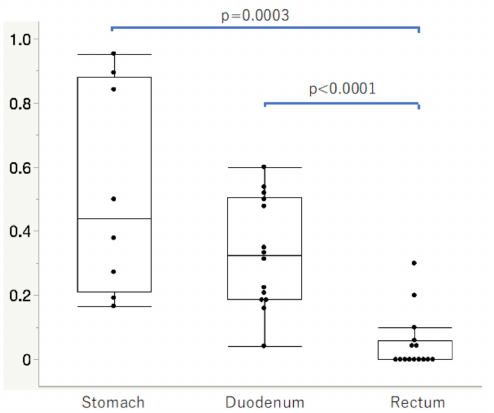
Figure 5. SSTR2-positive rates in the normal neuroendocrine cells of gastrointestinal mucosa in Group 4 cases. SSTR2-positive rates in the stomach and duodenum were significantly higher than those in the rectum ( p = 0.0003, p < 0.0001,